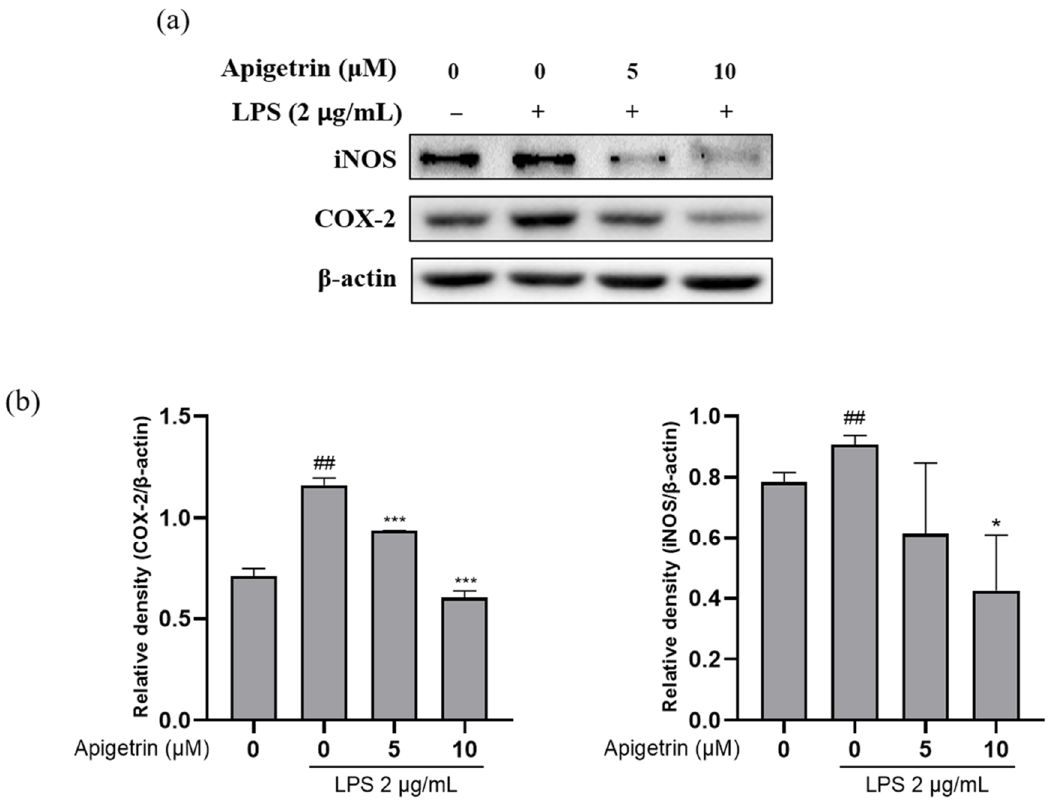
Figure 3. ( a ) Effect of apigetrin on the expression of iNOS and COX-2. L6 cells were treated with apigetrin (0, 5, and 10 μM), with or without LPS (2 μg/mL), for 24 h. Protein expression was determined by Western blotting. ( b ) The results are presented as the mean ± standard deviation (SD) of three independent experiments. ## p < 0.01 vs. untreated group; * p < 0.05 vs. LPS-alone-treated group; *** p < 0.001 vs. LPS-alone-treated